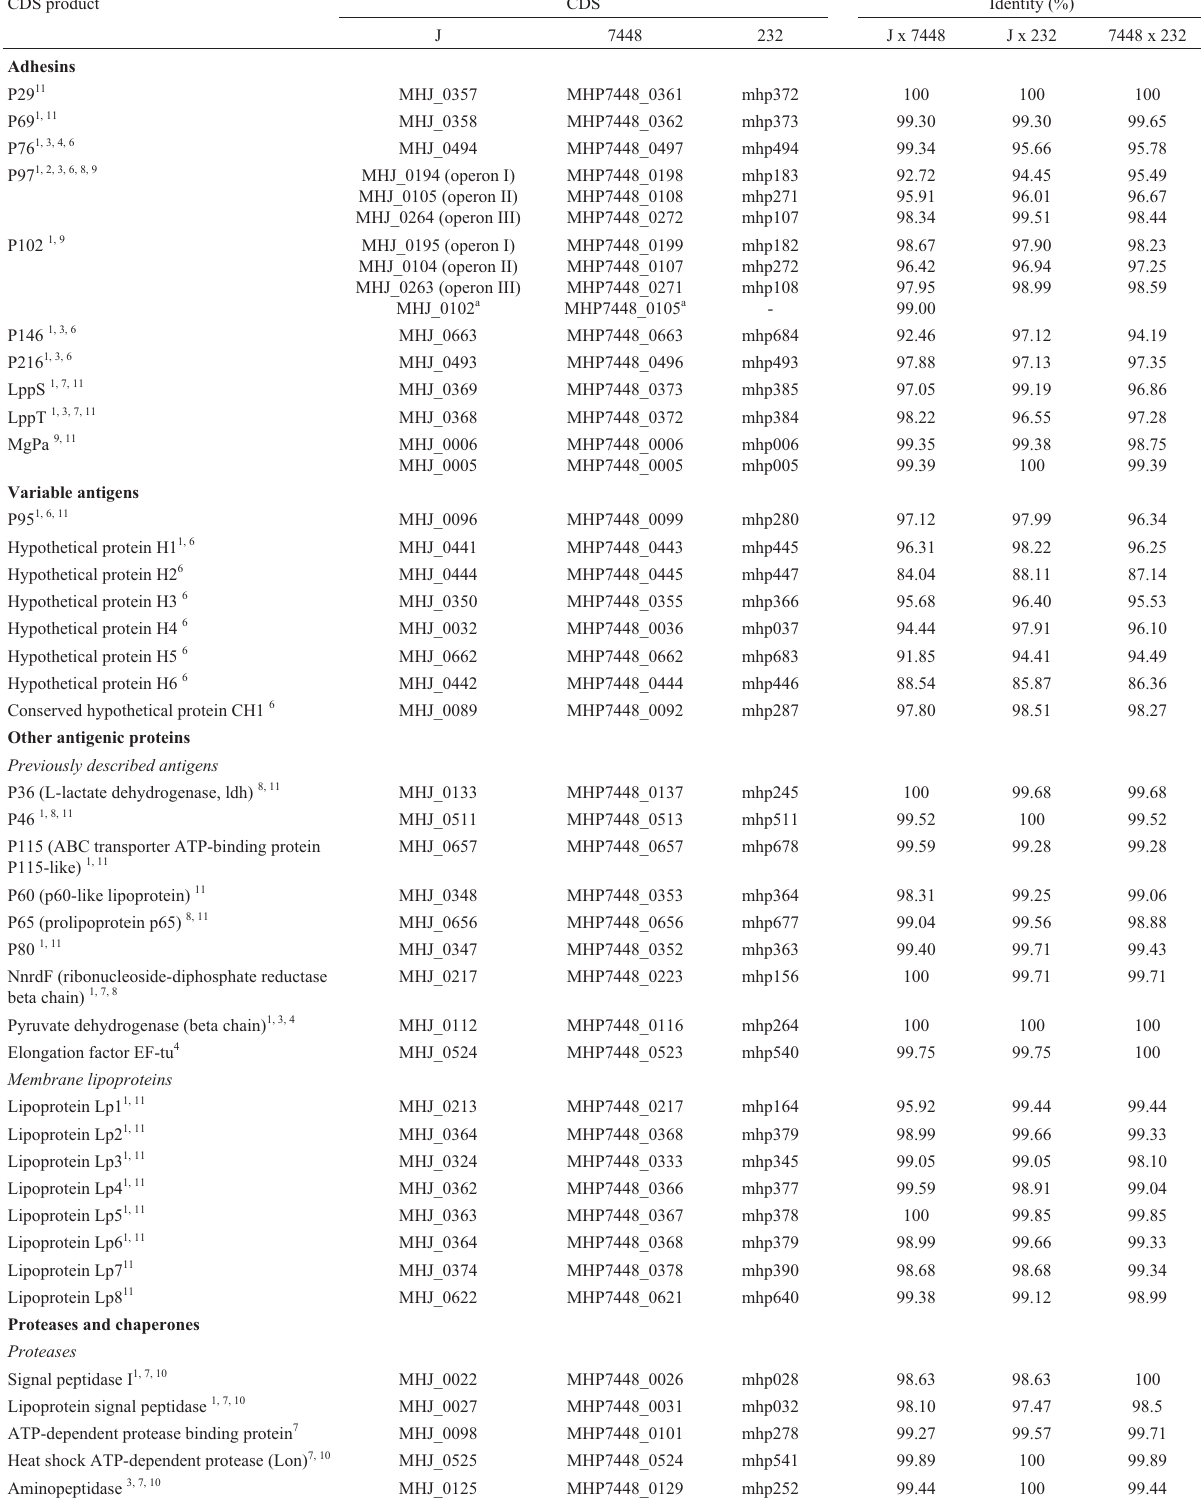
Table 1 - List of CDSs encoding virulence factors in M. hyopneumoniae strains J, 7448 and 232, and identities between the corresponding orthologous deduced amino acid sequences of the different strains. The CDSs were classified according to the text and include CDSs encoding both previously described and putative virulence factors. Any additional criterium(a) used to assign a given CDS product as a virulence factor is(are) indicated (superscriptednumbers),aswellasanyadditionalcriterium(a)toestablishorthology(superscriptedletters).CDSnumbersareaccordingtoGenBankand